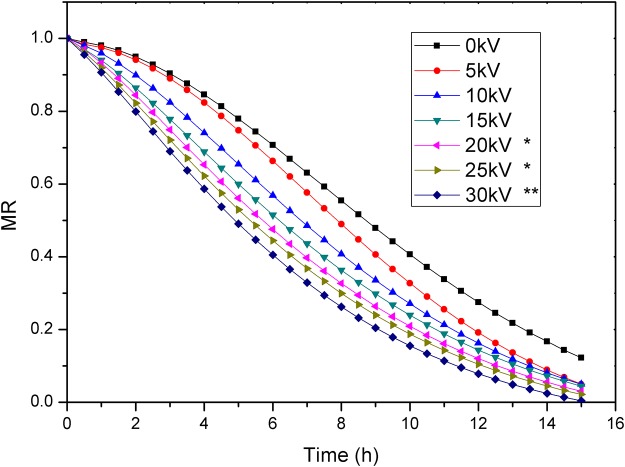
Moisture ratio of carrots under different voltages.*p<0.05, significant difference; **p<0.01, very significant difference.